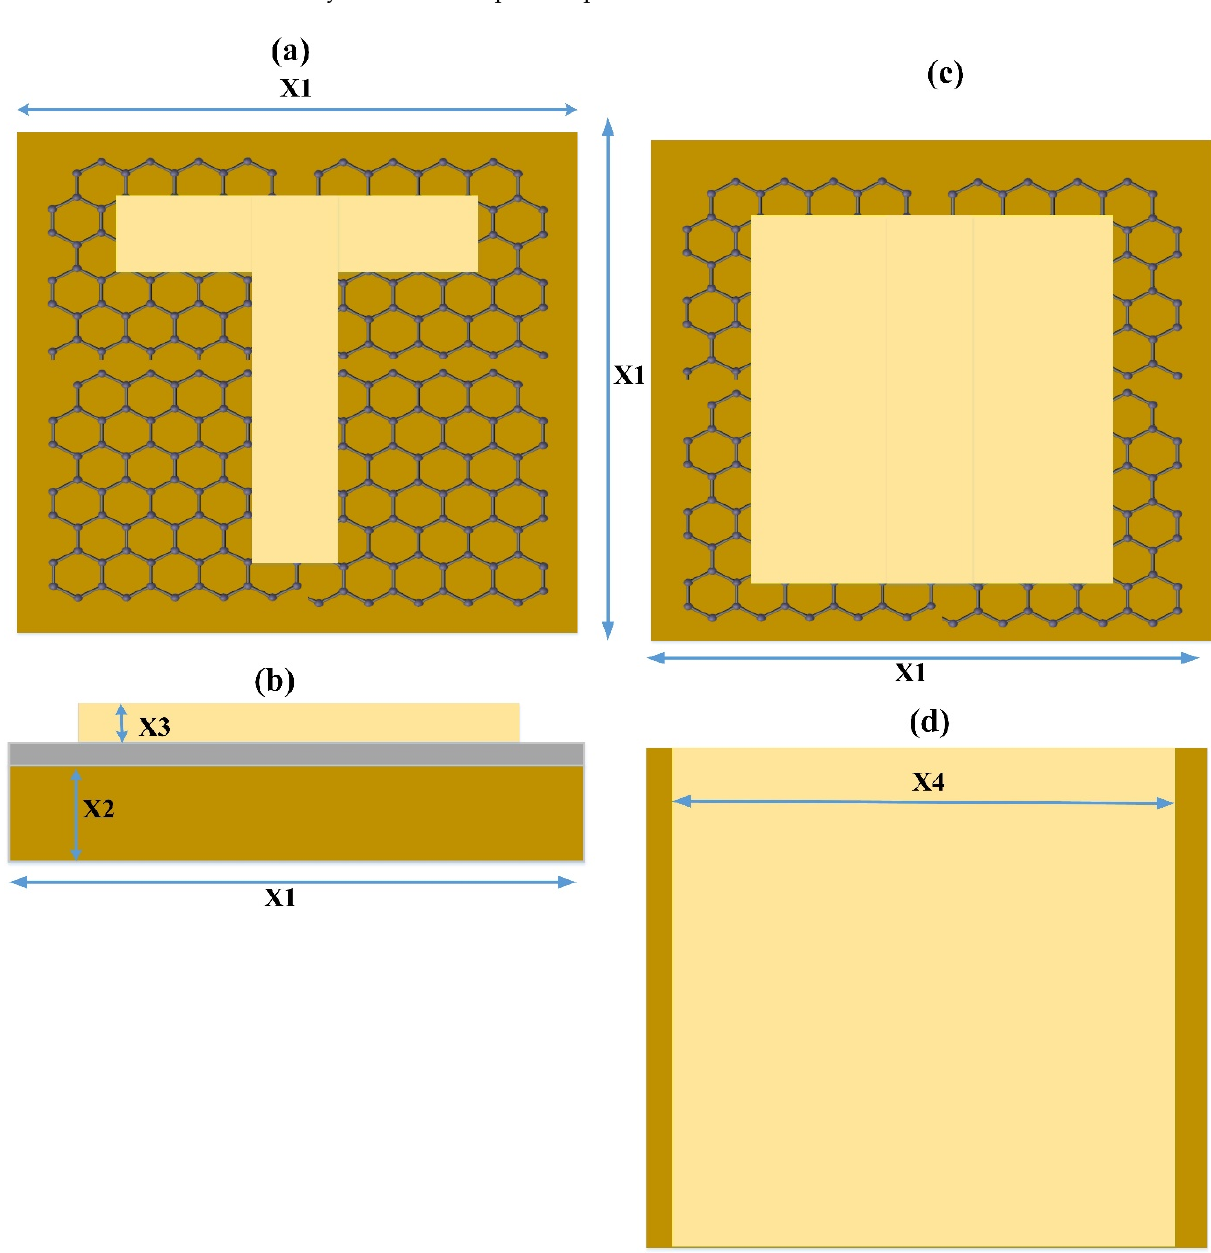
Figure 1. Solar absorber design with three different metasurfaces. ( a ) and ( b ) T-shape metasurface absorber. ( c ) Square-1 metasurface absorber design. ( d ) Square-2 metasurface absorber design. The design parameter values are X1 = 3000 nm, X2 = 2500 nm, X3 = 1000 nm, X4 = 2800 nm. The T-shape length and width are 2500 nm and square-1 shape size is also 2500 nm.